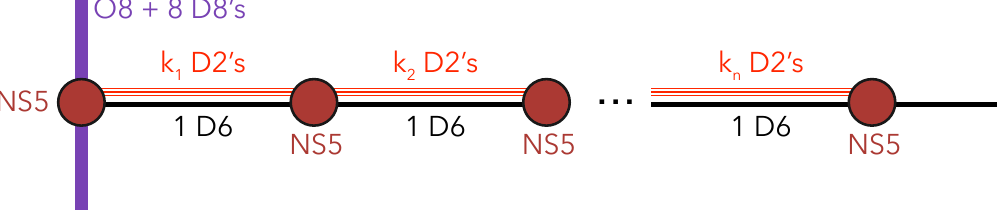
Figure 6. IIA brane system which uplifts to E-string theory on multiple